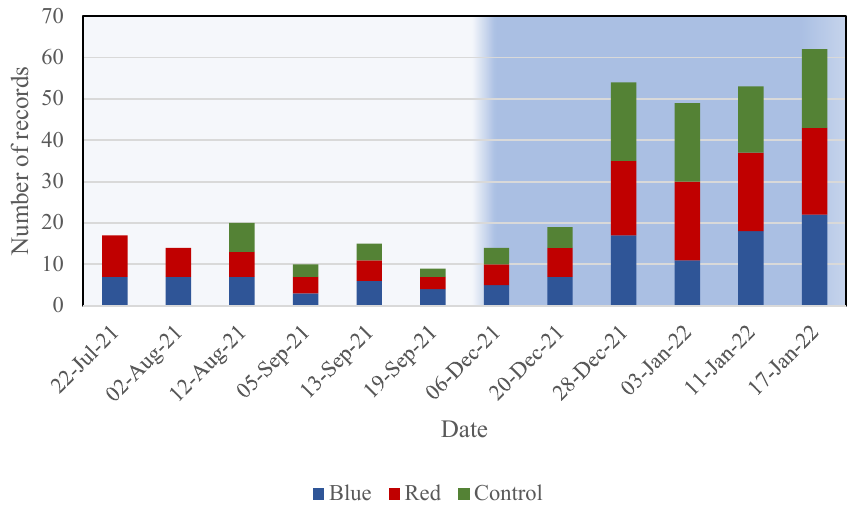
Figure 3. Number of records per day, divided stacked by greenhouse. Data of summer and winter growing seasons, from 22 July to 19 September 2021 (light blue background) and 6 December 2021 to 17 January 2022 (darker background), respectively.